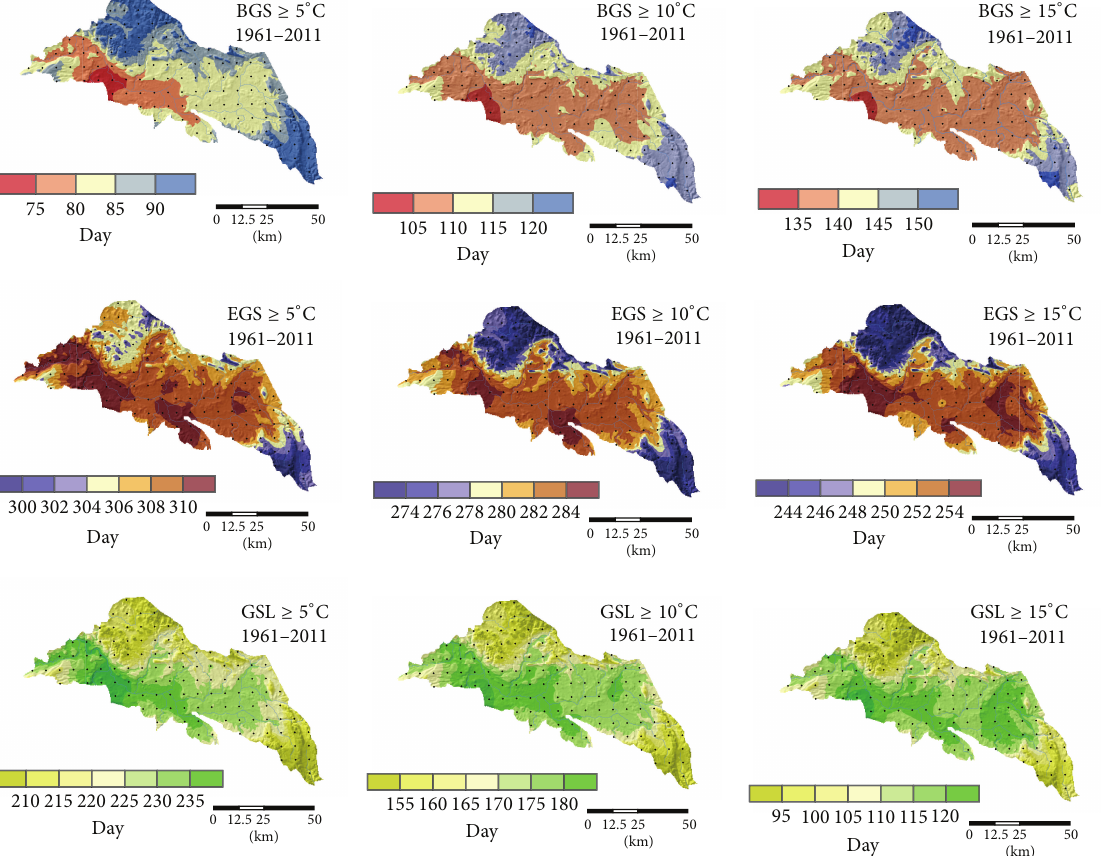
Figure 4: Spatial variability of the mean values of BGS, EGS, and GSL for the 5, 10, and 15 ∘ C temperature thresholds from 1961 to 2011 in the Elbe River